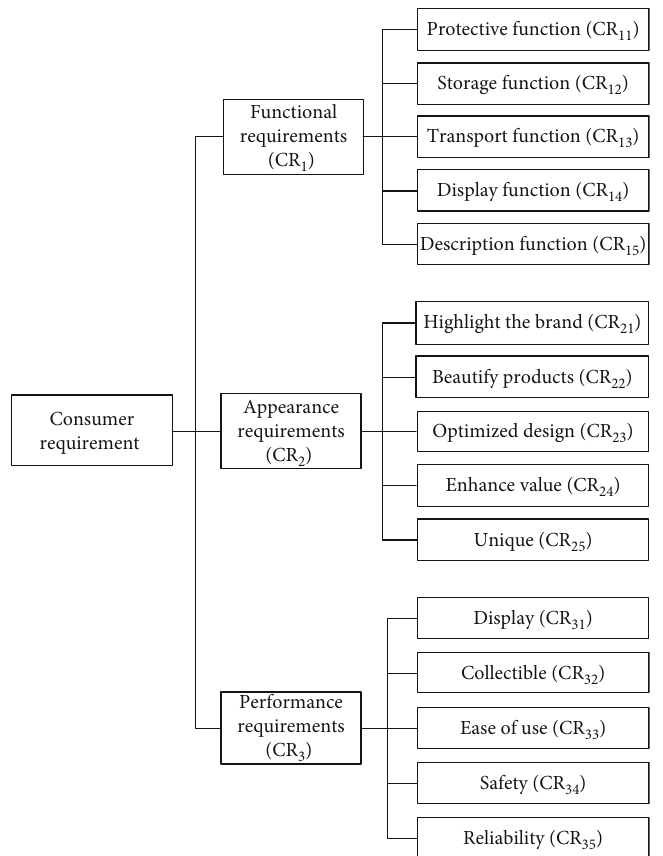
Figure 1: Three consumer demands for jewelry